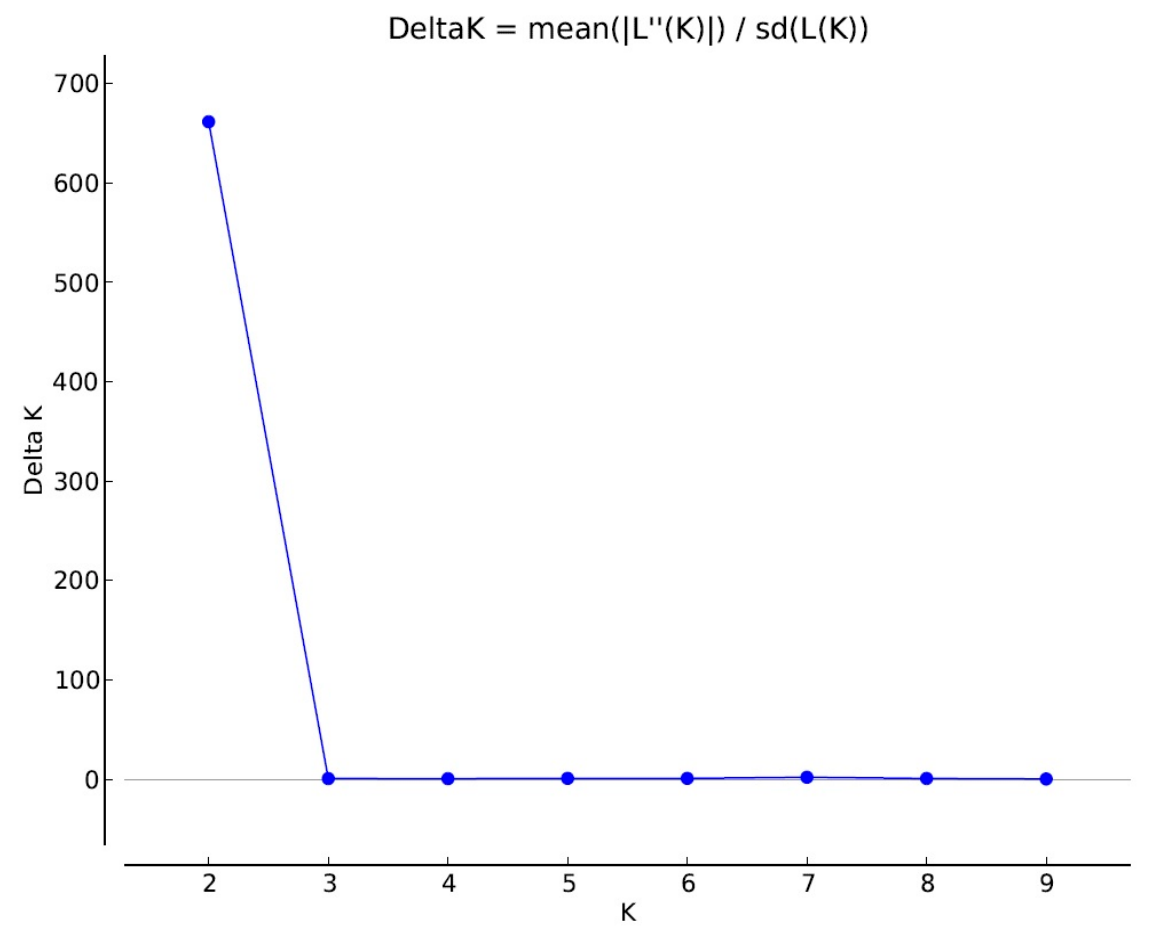
Figure 3. The Delta K plot showing the highest pick at K = 2 (the most probable number of genetic clusters).